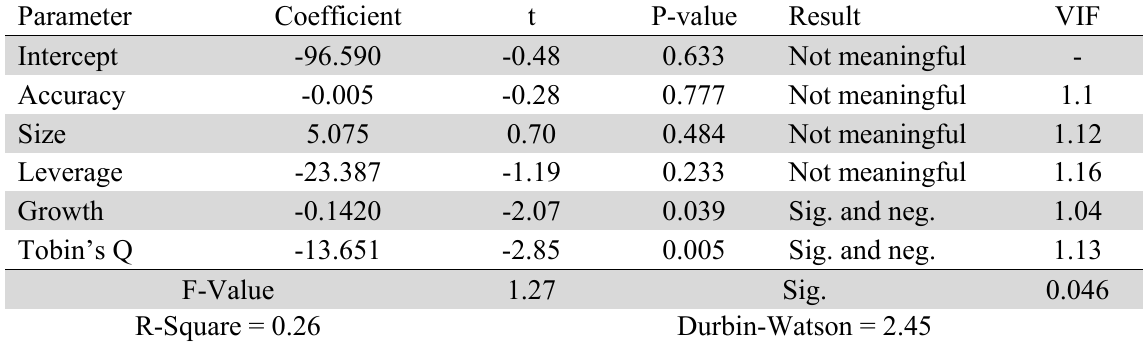
The summary of regression analysis for the second hypothesis